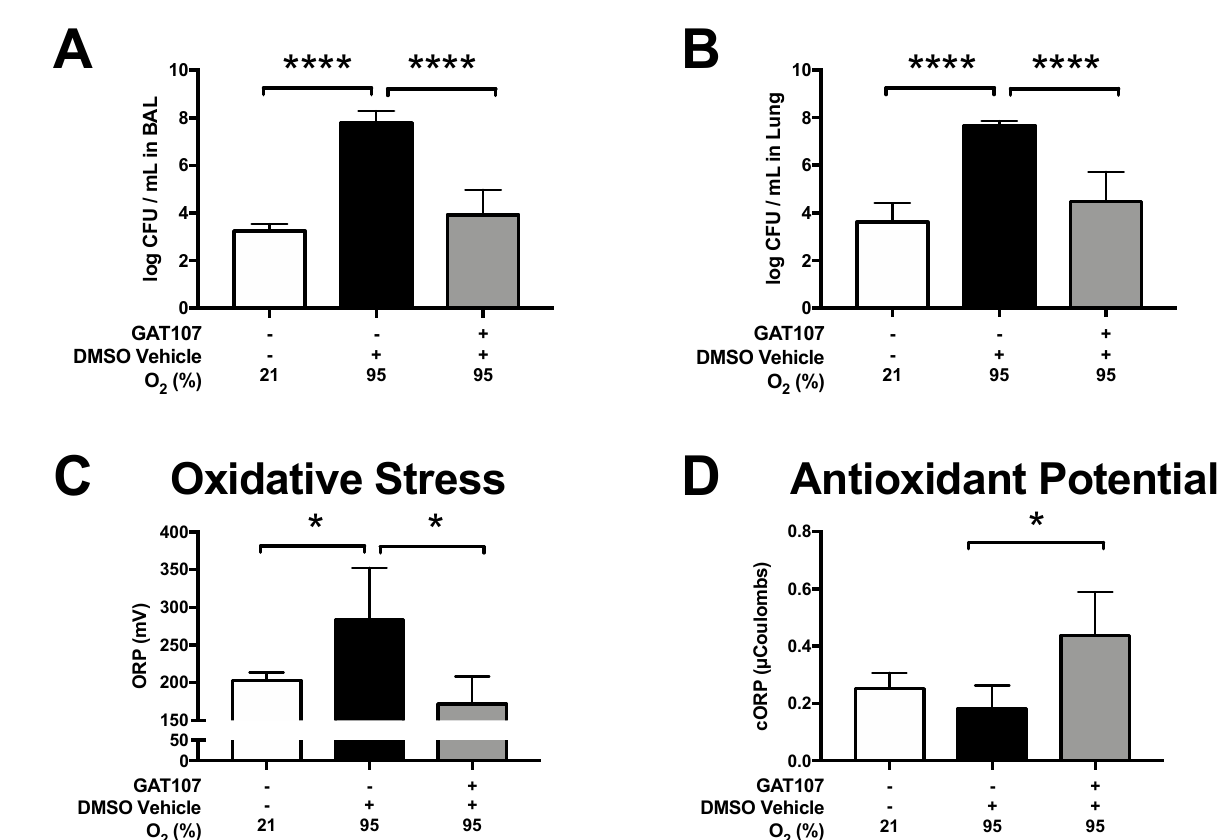
Figure 1. The intraperitoneal administration of GAT107 increases bacterial clearance and attenuates the hyperoxia-induced redox imbalance in mice challenged with intra-tracheal Pseudomonas aeruginosa. Mice exposed to >95% O 2 (hyperoxia) for 48 h, inoculated with PA (0.1 × 10 8 CFUs/mouse) and then returned to 21% O 2 after inoculation. Mice were randomized to receive 3.3 mg/kg of GAT107 or vehicle intraperitoneally, every 12 h, starting after 24 h of exposure to hyperoxia. Bronchoalveolar lavage (BAL) and lung tissue were harvested 24 h after inoculation. Viable bacteria in the airways and lungs were quantified by plating serials dilutions of ( A ) BAL and ( B ) lung homogenate and were expressed as the log of colony-forming units (CFUs) per mL. Data represent the mean ± SEM based on n = 6–7 mice per group. Statistical differences were determined between all groups and indicated as **** p < 0.0001 compared to the hyperoxia-exposed group treated with vehicle (i.e., the control group). Lung homogenate was analyzed for ( C ) oxidative-reduction potential (ORP), expressed as millivolts (mV) and ( D ) the capacity of the ORP or total antioxidant potential (cORP), expressed as µCoulombs (µC), by the RedoxSys System. Data represent the mean ± SEM of two-independent experiments based on n = 4 mice per group. Statistical differences were determined between all groups and indicated as * p < 0.05 compared to the hyperoxia-exposed group treated with